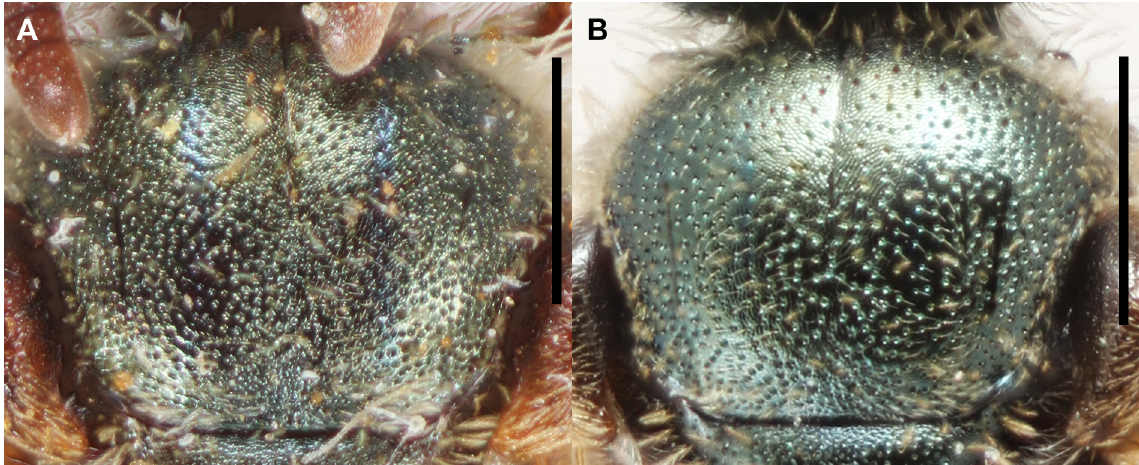
Fig. 93. Mesoscutum. A . Lasioglossum tegulariforme (Crawford, 1907), ♀, finely and very densely